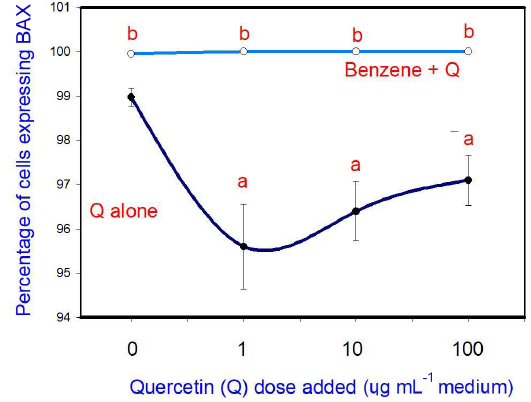
Figure 2. Effects of benzene, quercetin extract, and their combina- tion on apoptosis in cultured porcine ovarian granulosa cells. Parts marked “a” show the effect of quercetin extract (significant differ- ence ( P< 0 . 05) between cells cultured without and with quercetin addition at three different levels without benzene), b the effect of benzene (significant difference ( P< 0 . 05) between cells cultured with or without benzene for each quercetin dose separately), and c the effect of quercetin extract at simultaneous benzene presence (significant difference ( P< 0 . 05) between a cell cultured with and without quercetin addition at three different levels with simultane- ous benzene addition); effect of benzene alone (20µgmL − 1 ) is dis- played for quercetin dose at 0µgmL − 1